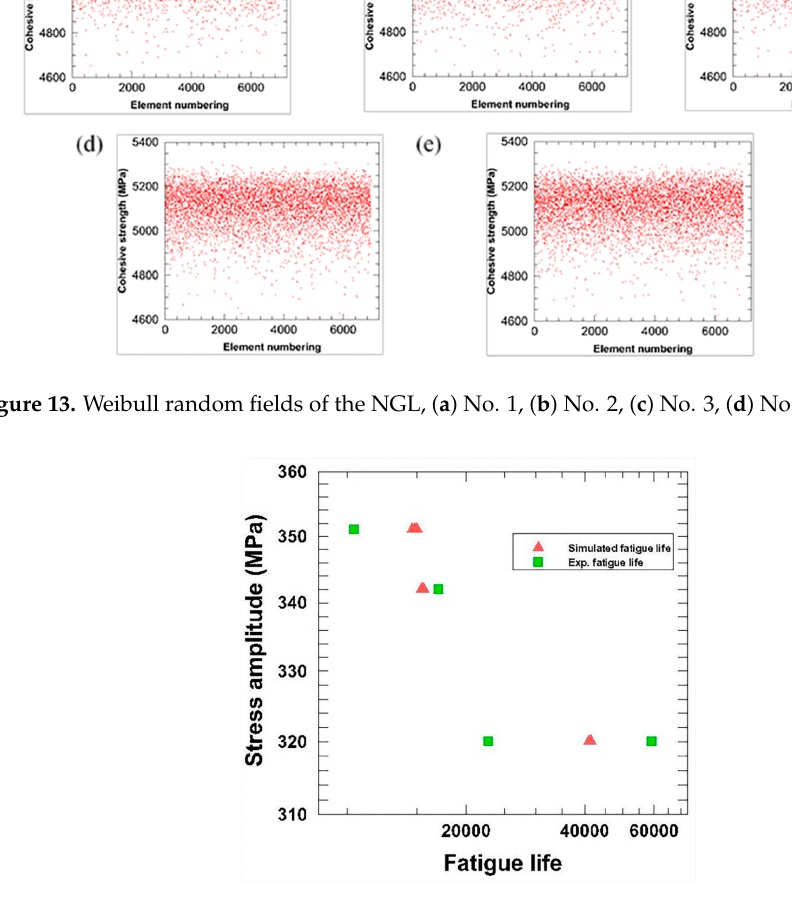
Figure 14. Simulated fatigue life of the SMATed specimen.